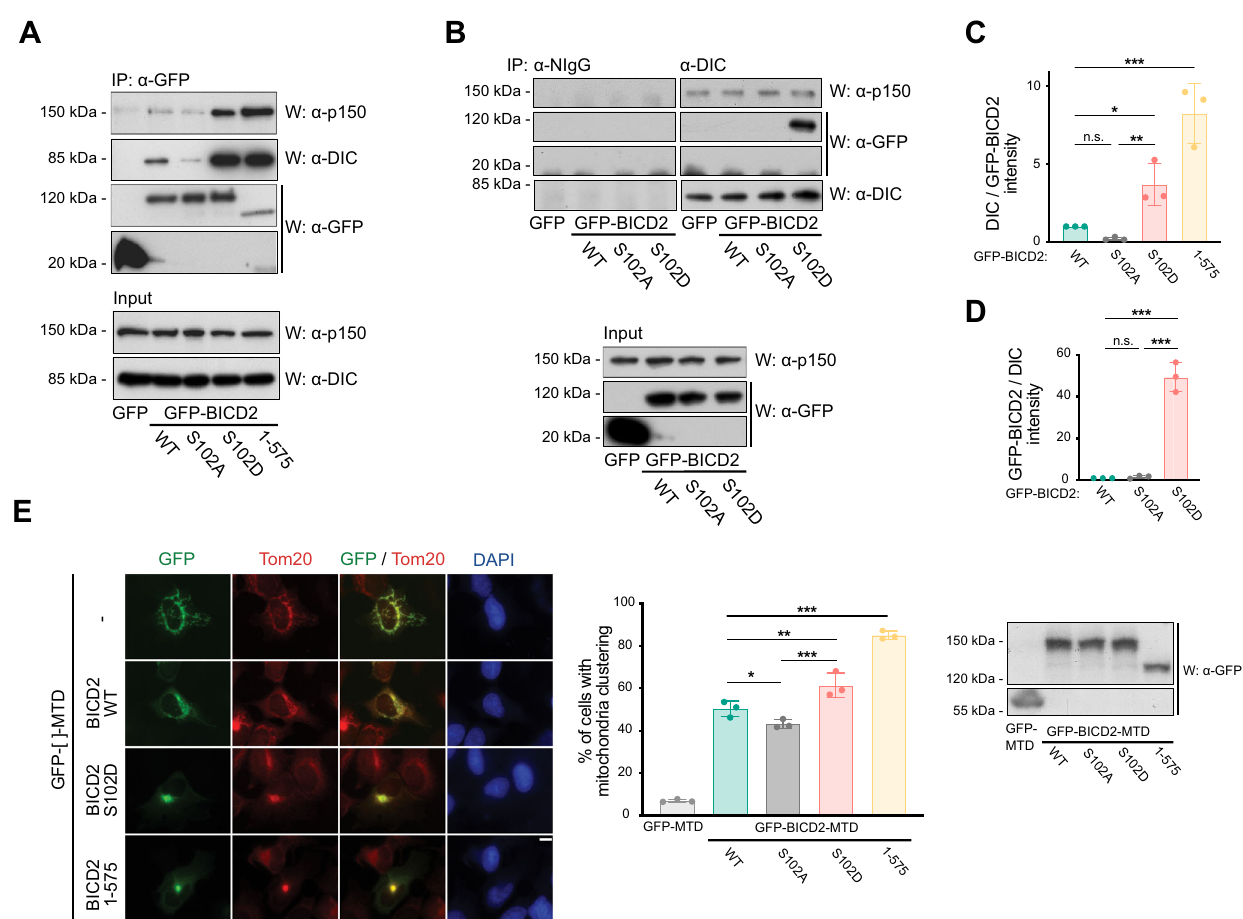
Fig. 3 | Modi fi cation of BICD2 at Ser102 is able to control dynein binding and mobility.A – D AphosphomimeticmutationinBICD2Ser102(BICD2S102D)results in increased dynein and dynactin binding to BICD2. A The indicated GFP-fusion proteins were immunoprecipitated ( IP ) from HeLa cells and analyzed by western blot( W )todetectdyneinanddynactin(usingrespectivelyanti-dyneinintermediate chain, DIC, and anti-p150 antibodies), plus GFP. DIC and p150 levels in the corre- sponding extracts are shown in the lower panel. B Normal IgG (NIgG) and anti-DIC immunoprecipitates from extracts expressing the indicated GFP-fusion proteins proved by western blot (W) with the indicated antibodies. Levels of GFP-fusion proteins plus p150 in the corresponding extracts are shown in the lower panel. C , D Quanti fi cation of the previous results. Top, DIC intensity/GFP-BICD2 intensity in the immunoprecipitates; mean±SD of three independent experiments (corre- sponding to A ). Bottom, GFP-BICD2 intensity/DIC intensity in the immunopreci- pitates; mean±SD of two independent experiments (corresponding to B ). Statistical signi fi cance analyzed using one-way ANOVA with post hoc analysis (no correction for multiple comparations, Fisher ’ s LSD test). In ( C ), WT vs. S102A, P =0.4380 (n.s.);WT vs. S102D, P =0.0.232 (*);WT vs. 1-575, P <0.0001 (***); S102A vs. S102D, P =0.0068 (**). In ( D ), WT vs. S102A, P =0.8631 (n.s); WT vs. S102D,